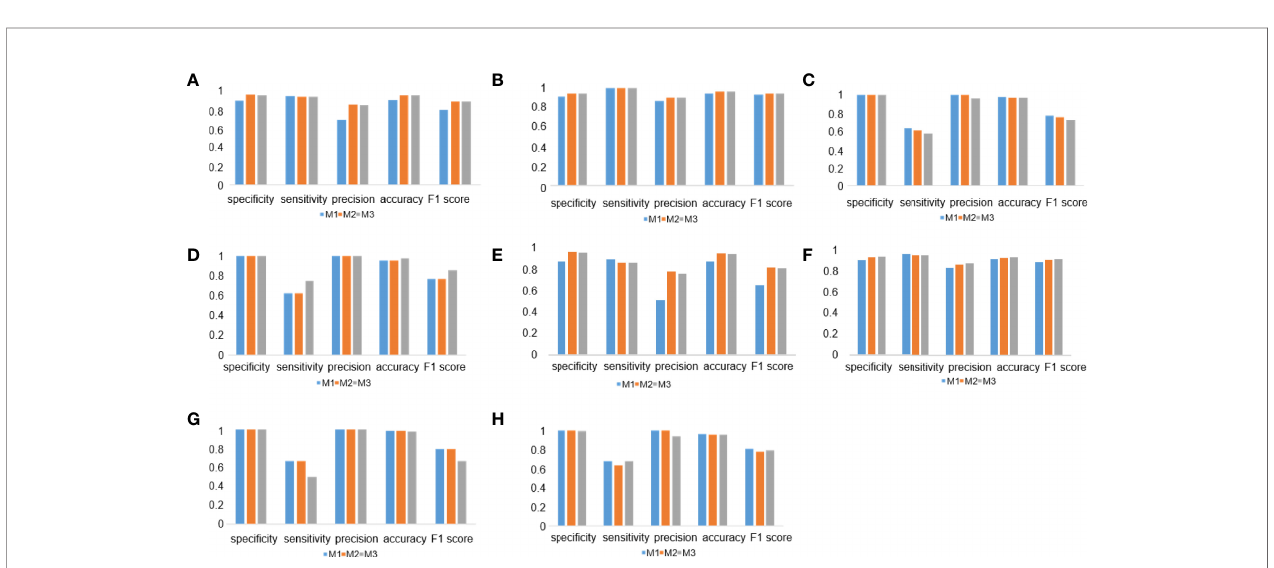
FIGURE 7 | Deep learning (DL) model performance in different tumor types and surgical methods. (A – D) Histograms of DL model performance of lung adenocarcinoma (A, C) and lung squamous cell carcinoma (B, D) at the cutoff of 1% (A, B) and 50% (C, D) . (D – F) Histograms of DL model performance of samples from surgery (E, G) and needle biopsy (F, H) at the cutoff 1% (E, F) and 50% (G, H) .